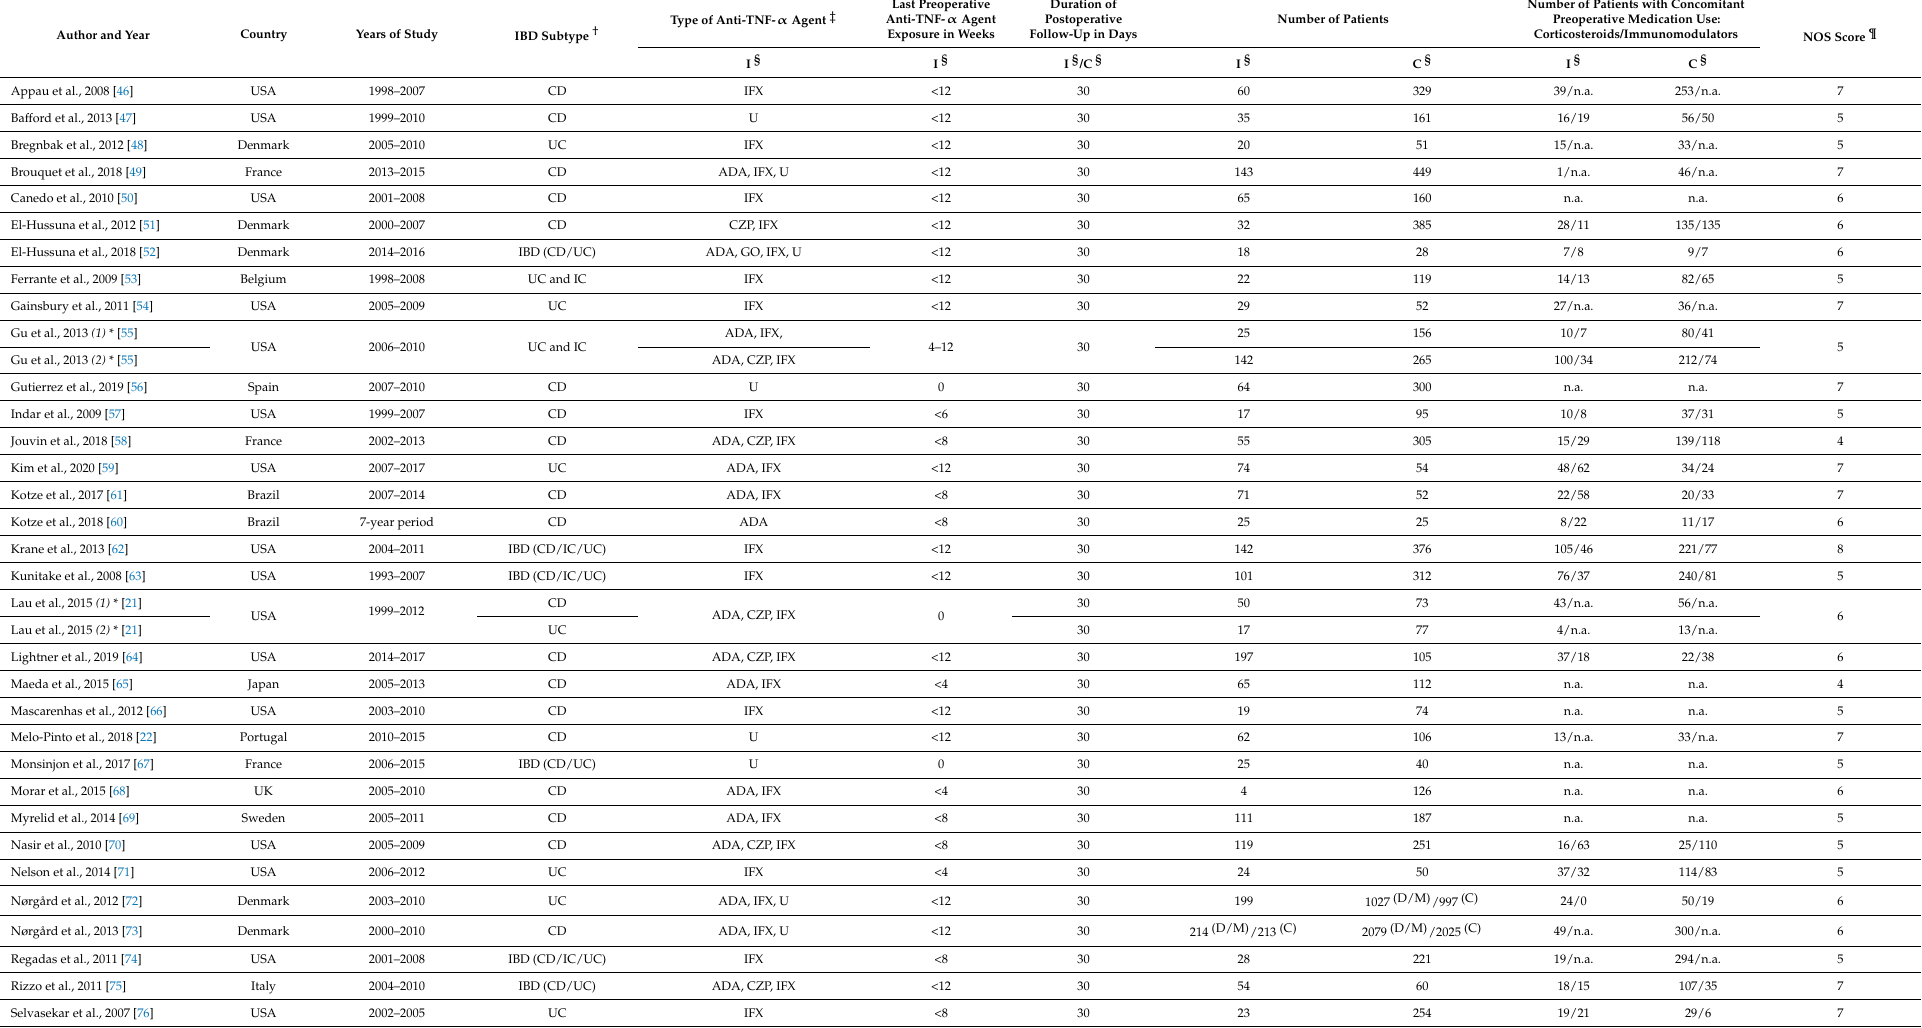
Table 1. Study and patient